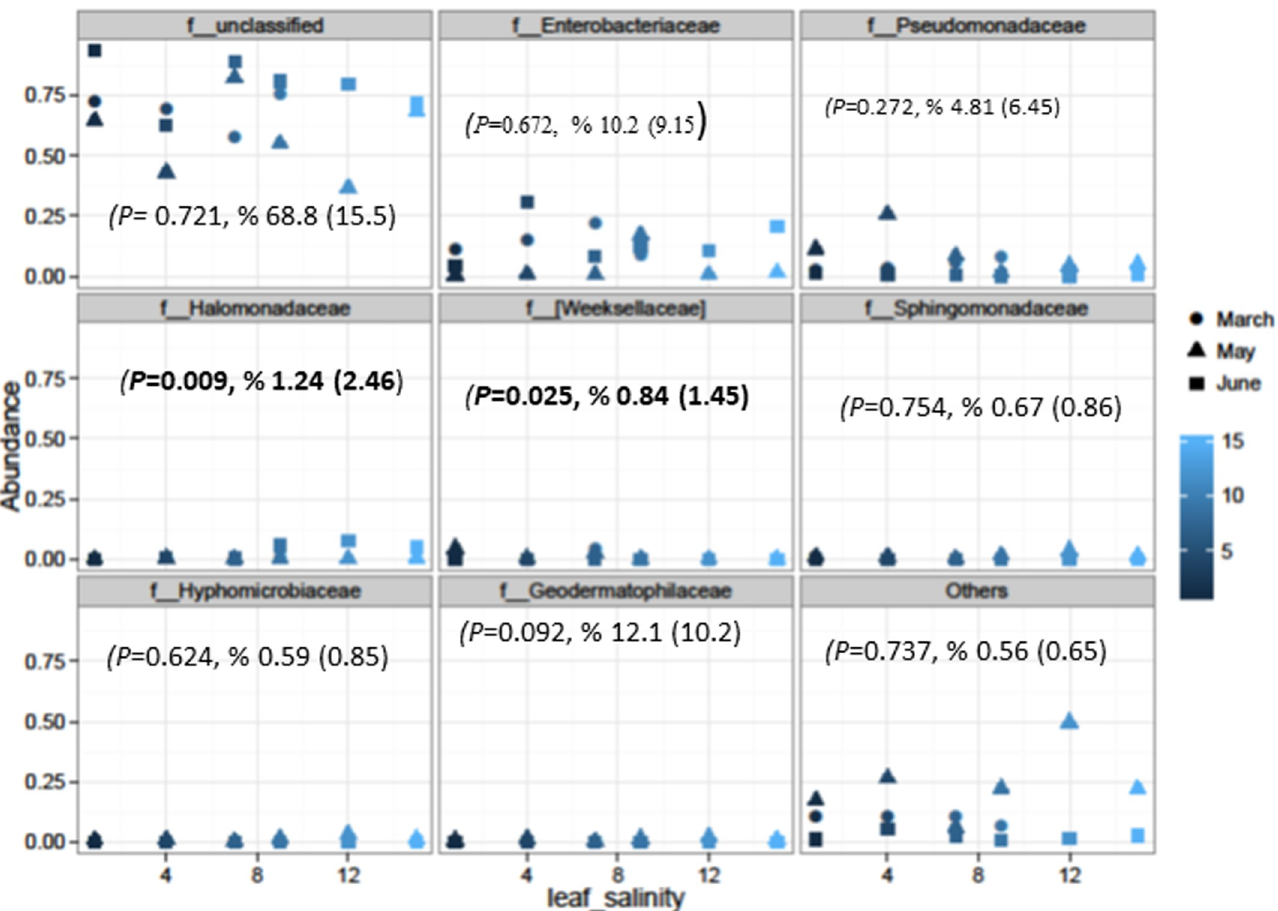
Fig 2. Most Abundant bacteria at the family level in the phyllosphere with no significant differences due to salinity except Halomonadaceae and Weeksellaceae . Spearman values are shown with relative abundance mean values with standard deviation